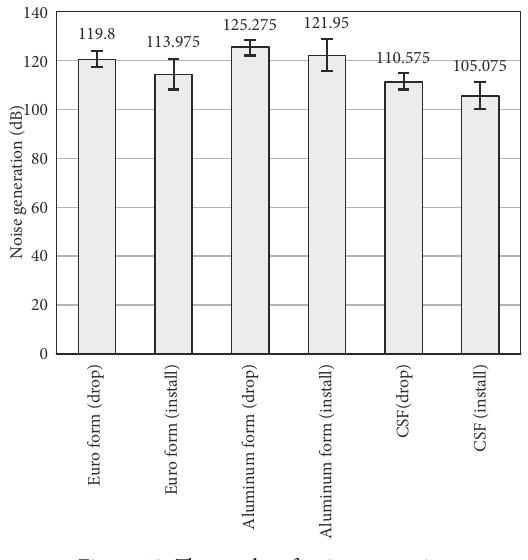
Figure 10. The results of noise generation